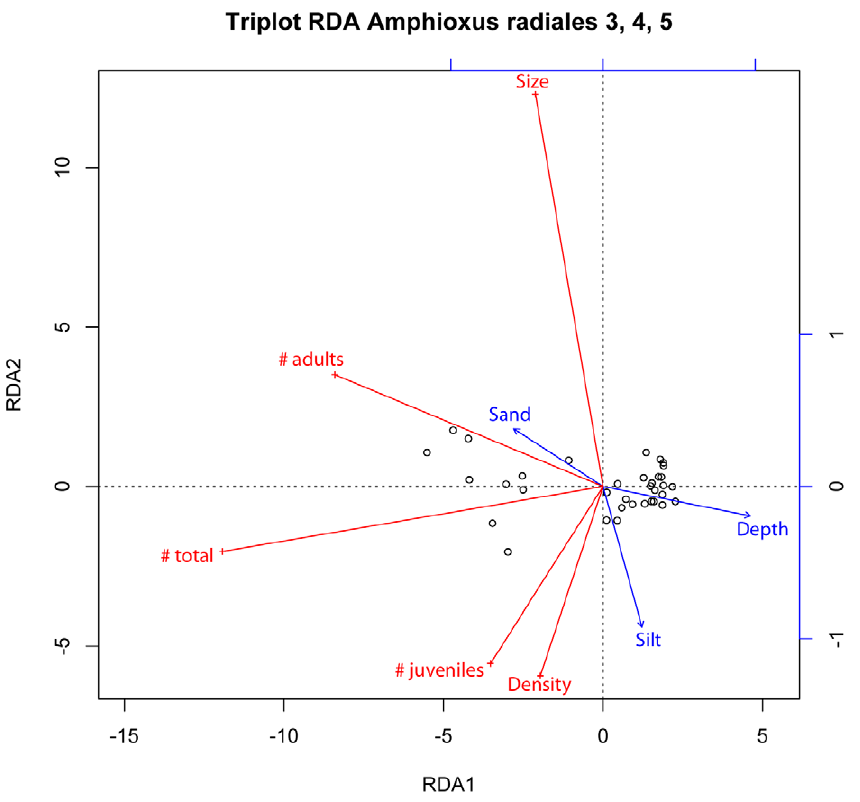
Figure 4. Triplot showing the result of the redundancy analysis of amphioxus size, number (of adults, juveniles, and all individuals) and density (in ind./l) constrained by environmental variables (percentage of sand and silt, and depth). Canonical axes 1 and 2 are represented (RDA1 and RDA2), accounting in total for 63.5% of the variation of the original dataset.